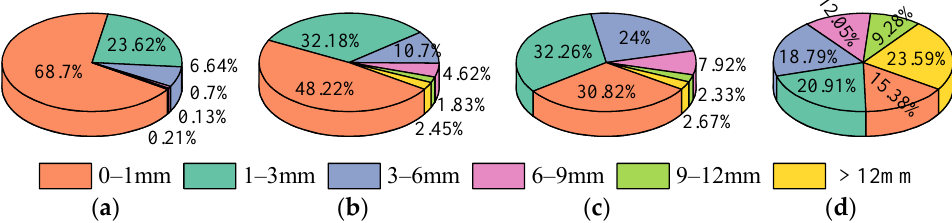
Figure 6. The diameter distributions of drilling cuttings from: ( a ) Shoushan coal mine; ( b ) Mengjin coal mine; ( c ) Pingdingshan 1 # coal mine; and ( d ) Tunliu coal mine with firmness coefficients of 0.18 – 0.22, 0.12 – 0.46, 0.21 – 2.61, and 0.44 – 0.53, respectively.